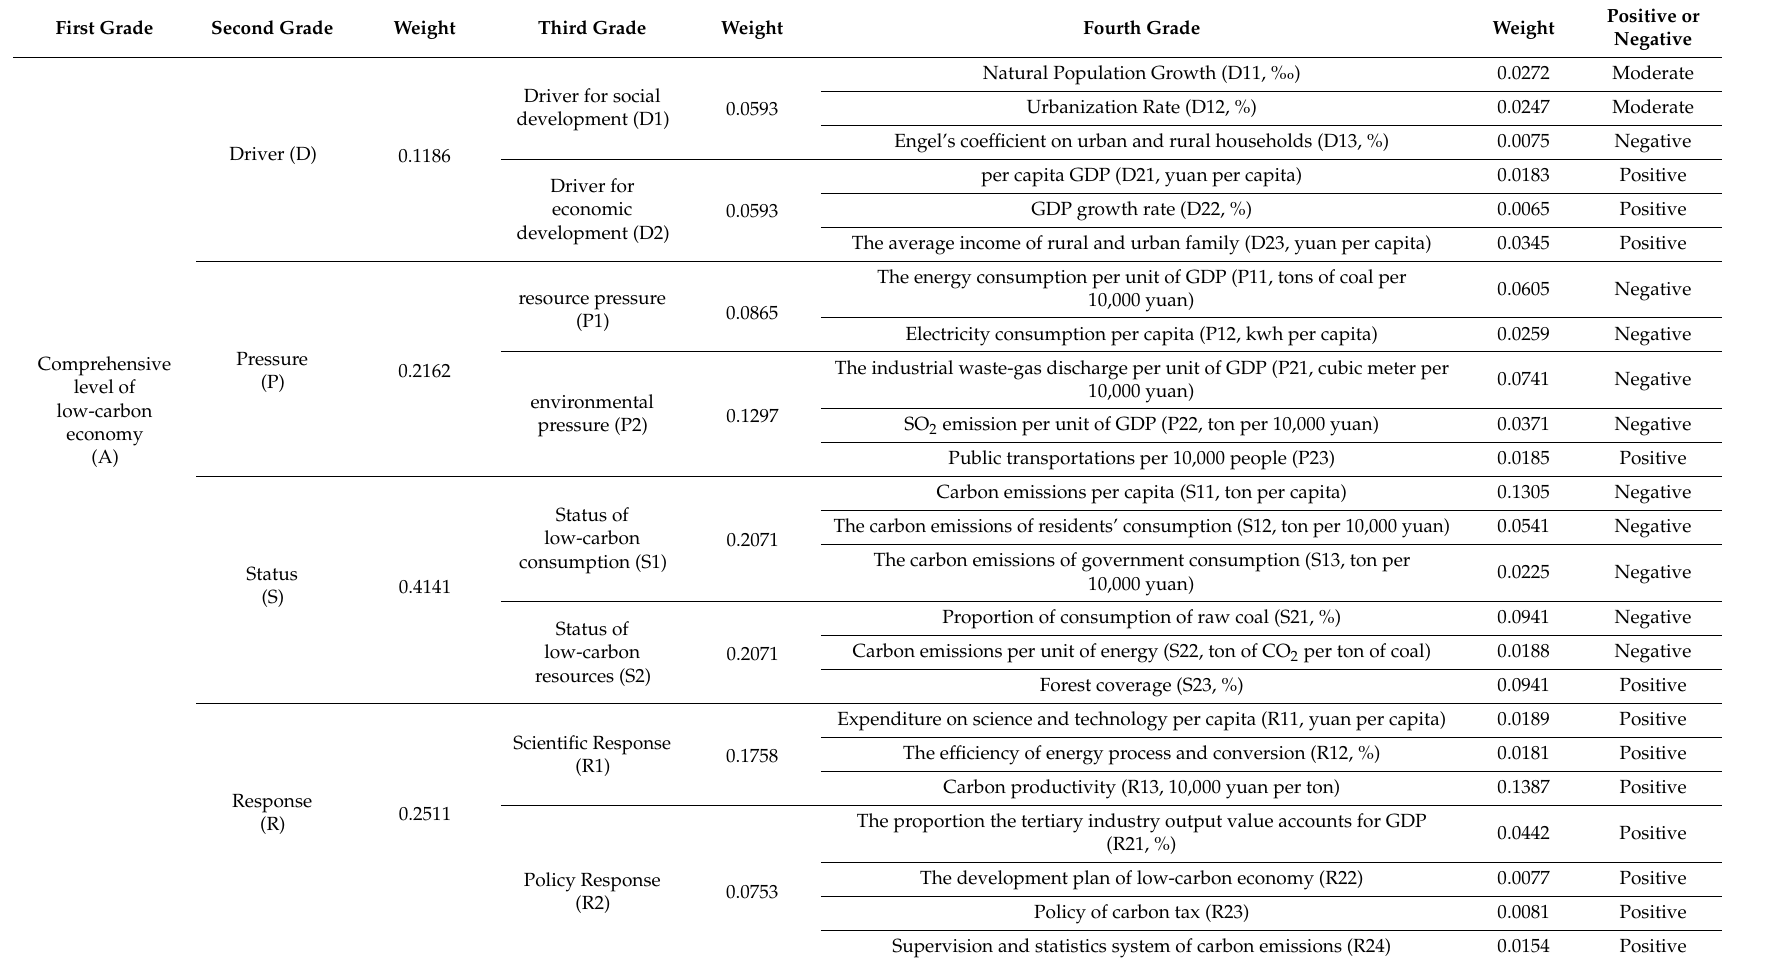
Table 1. Index system of low-carbon